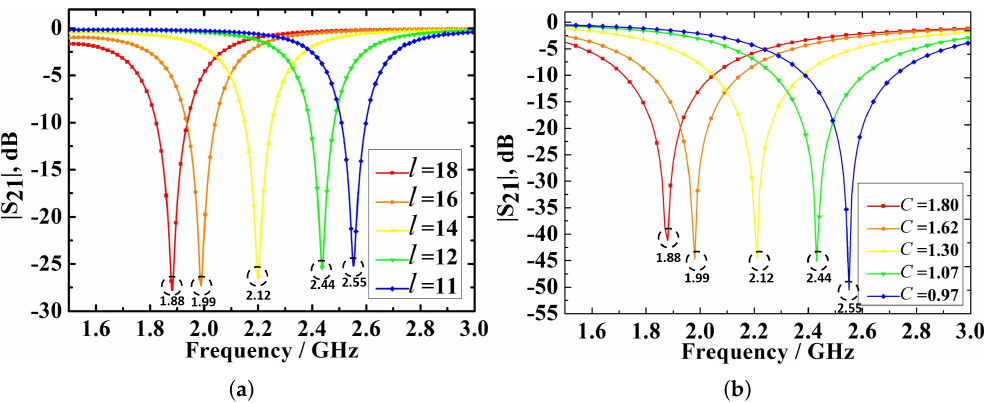
Figure 4. S 21 with different widths of metal patches when the diode is in on-state by ( a ) full wave and ( b ) equivalent circuit